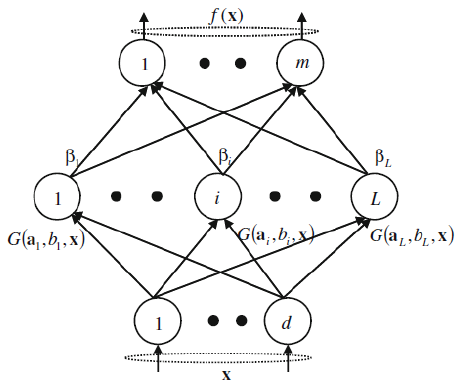
Figure 1. The architecture of SLFNs.